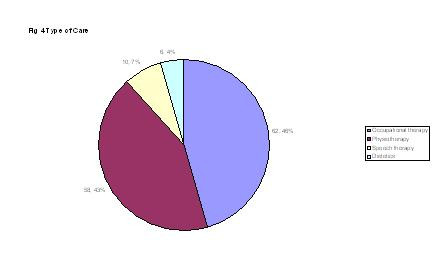
Types of care/therapy required.